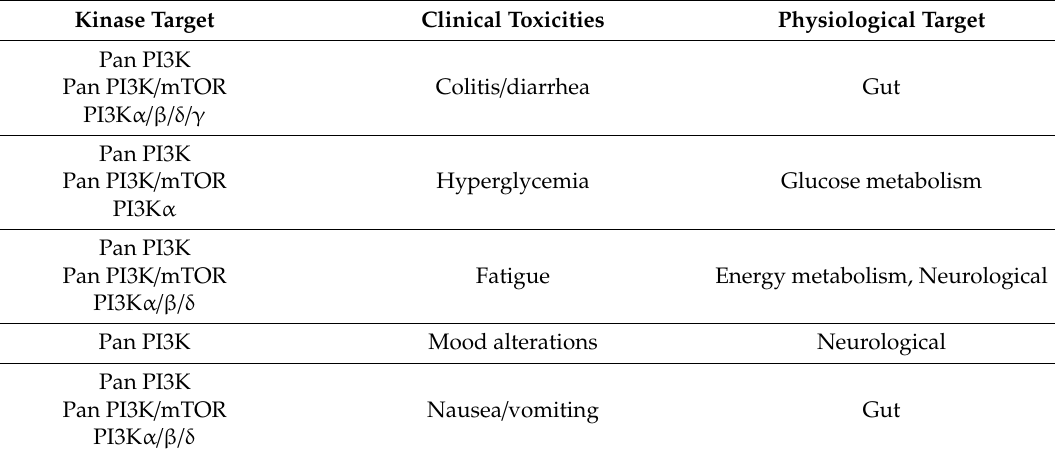
Table 2. Clinical toxicities associated with PI3K inhibitor use. The most likely physiological target for the named toxicity is also